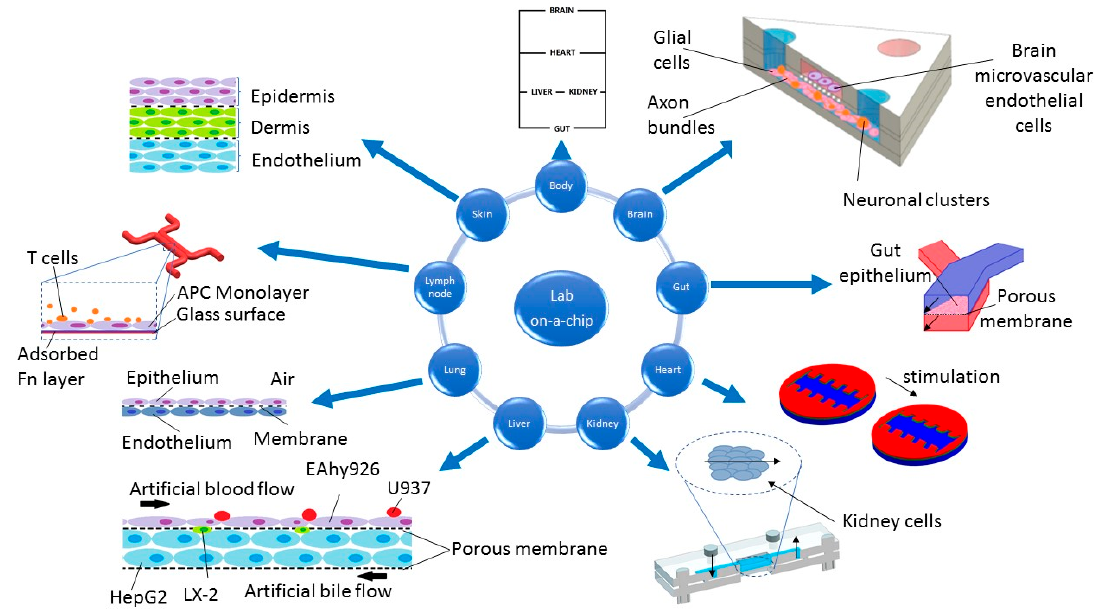
Figure 3. Example uses of lab on-a-chip systems. All figures within this figure were prepared on the basis of original papers (body [15], brain [16], gut [17], heart [18], kidney [19], liver [20], lung